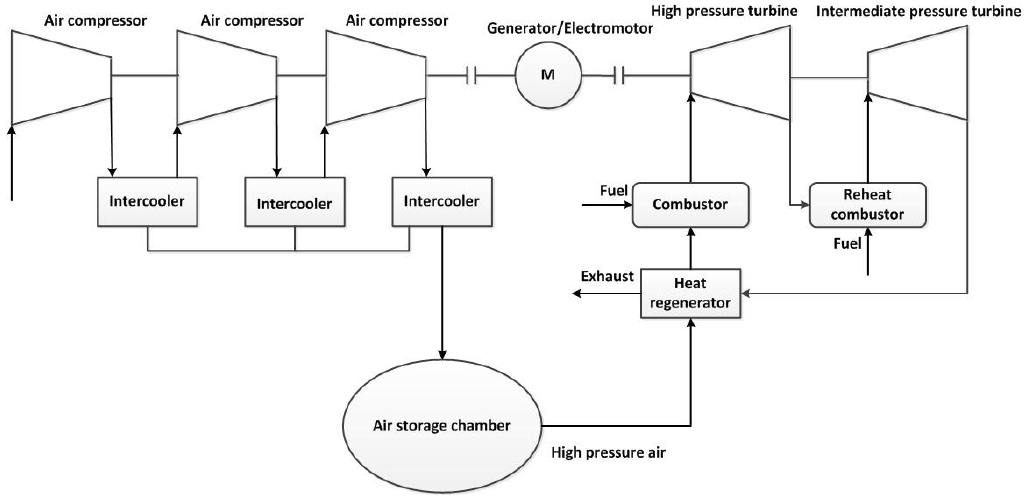
Figure 6. Schematic of the improved CAES